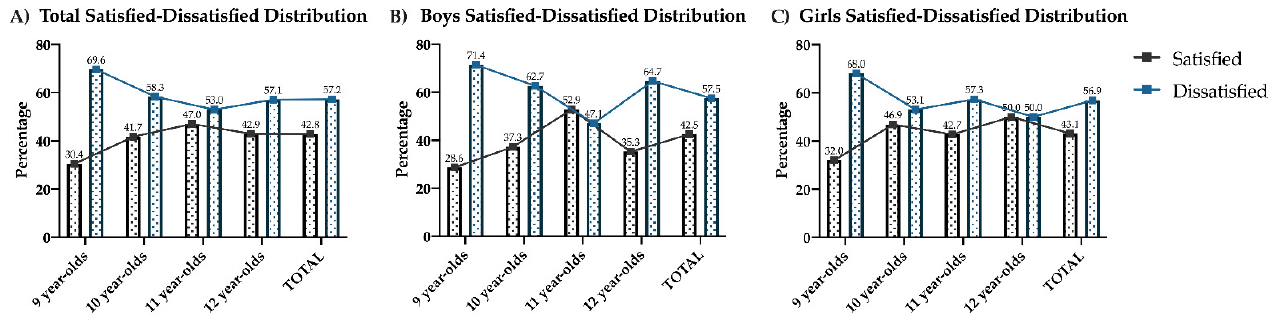
Figure 1. Body image satisfaction and dissatisfaction of boys and girls according to age. ( A ) Total distribution (boys and girls); ( B ) boys Distribution; ( C ) girls Distribution.